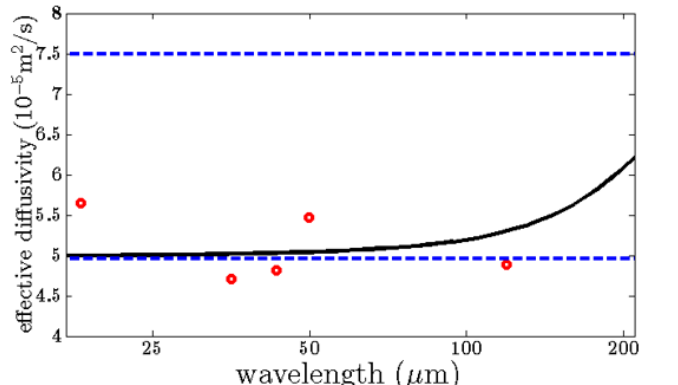
Figure 18. Simulated thermal dispersion curve (solid gray line) for the GESA modified material using the obtained fitting results. The dispersion curve is bounded by the thermal diffusivities of the coating and substrate. Also, effective thermal diffusivities extracted from each decay trace in Figure 15 were added (open red circles). The scatter on these points reveals the experimental